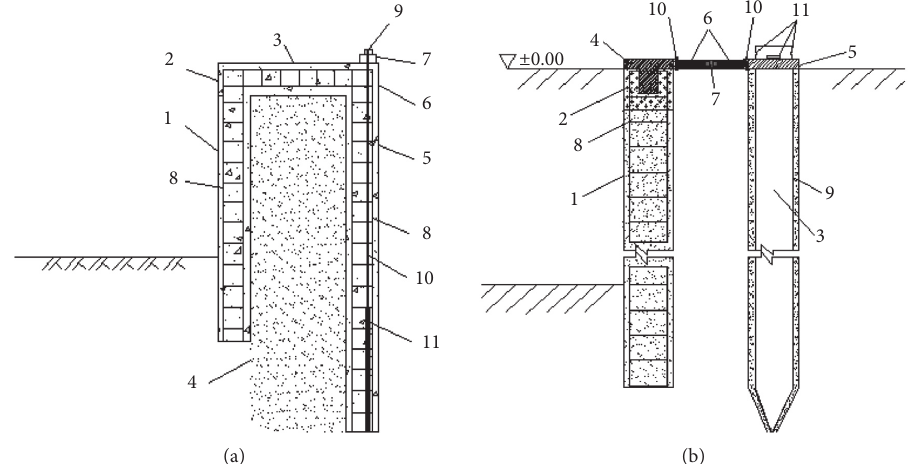
Figure 4: Elevation view of new double-row piles. (a) Prestressed strong-constrained double-row piles. (b) Recycling assembled double-row